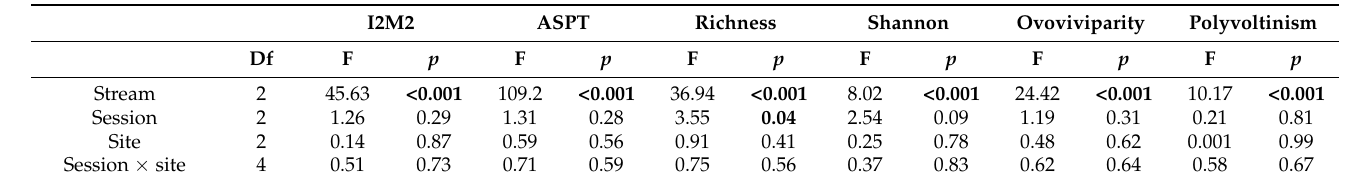
Table 3. Results of the ANOVA for the effects of stream, session, the sampling site and their in- teraction on the I2M2 and the five taxonomy-based metrics (Df = degree of freedom; F: F value; p : p -value, bold when significant; ASPT: Average Score Per Taxon; Richness: taxonomic richness and Shannon: Shannon’s diversity index; Ovoviviparity: relative abundance of ovoviviparous species; polyvoltinism: relative abundance of the polyvoltine species).